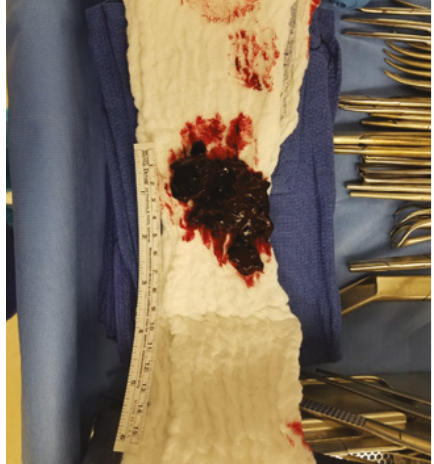
Figure 6: Hematoma evacuated from the anterior compartment of the